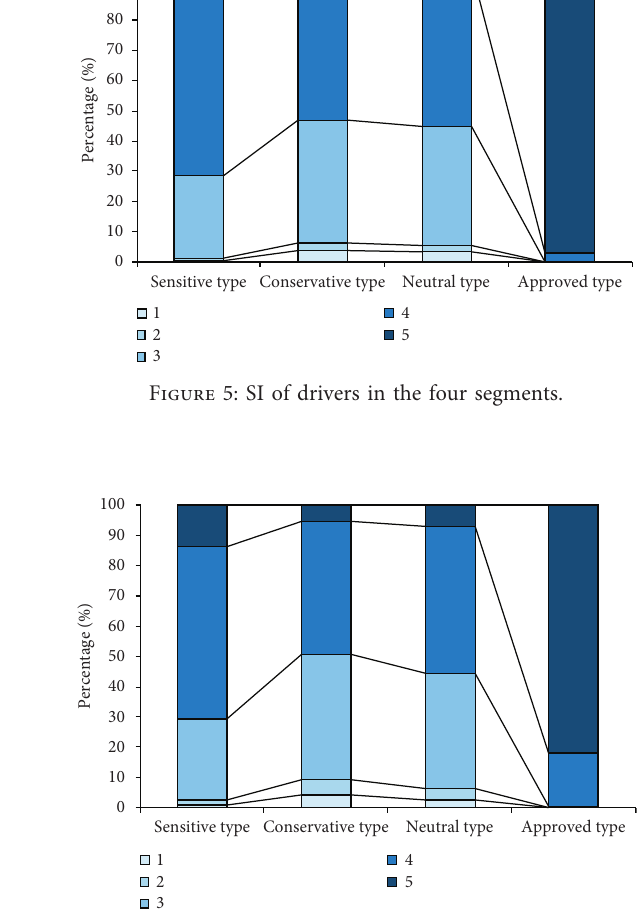
Figure 6: FC of drivers in the four